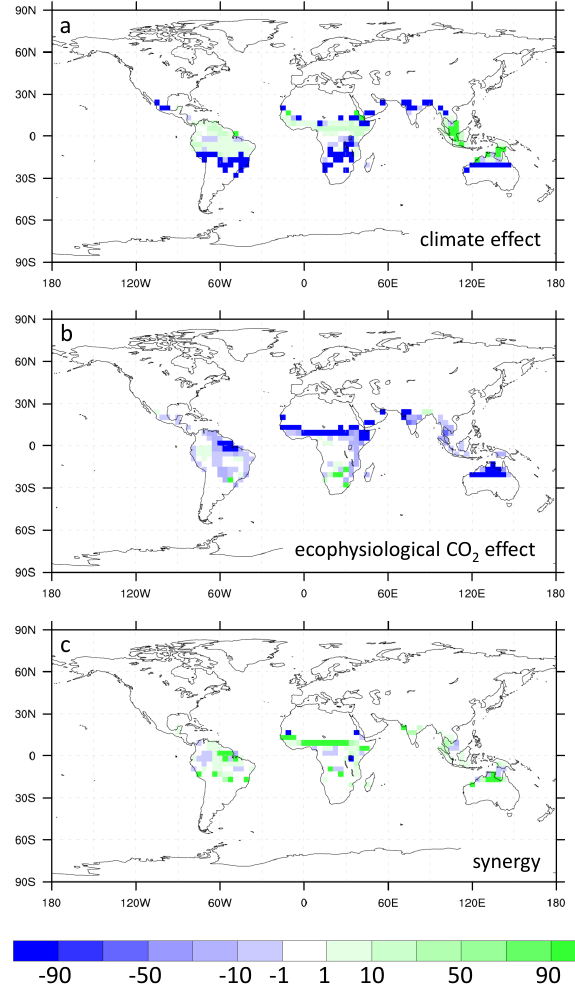
Fig. 7. Differences between glacial and pre-industrial vegetation patterns in terms of fractional coverage by tropical evergreen